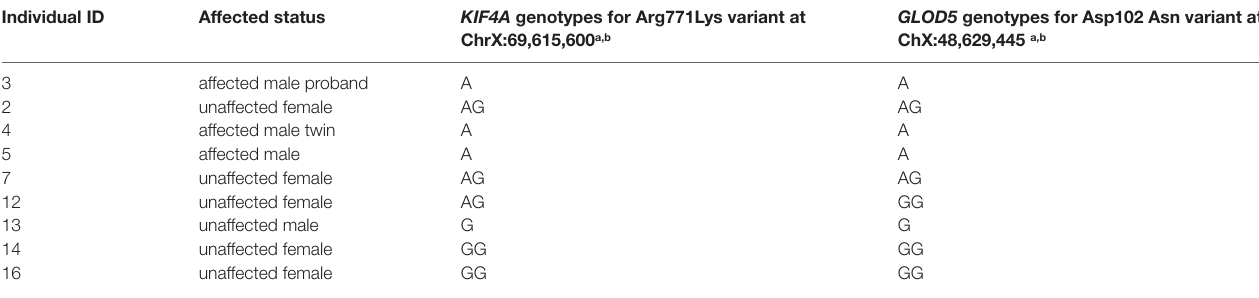
TABLE 2 | Genotypes of KIF4A and GLOD5 variants obtained through Sanger Sequencing for available members of family. Individual